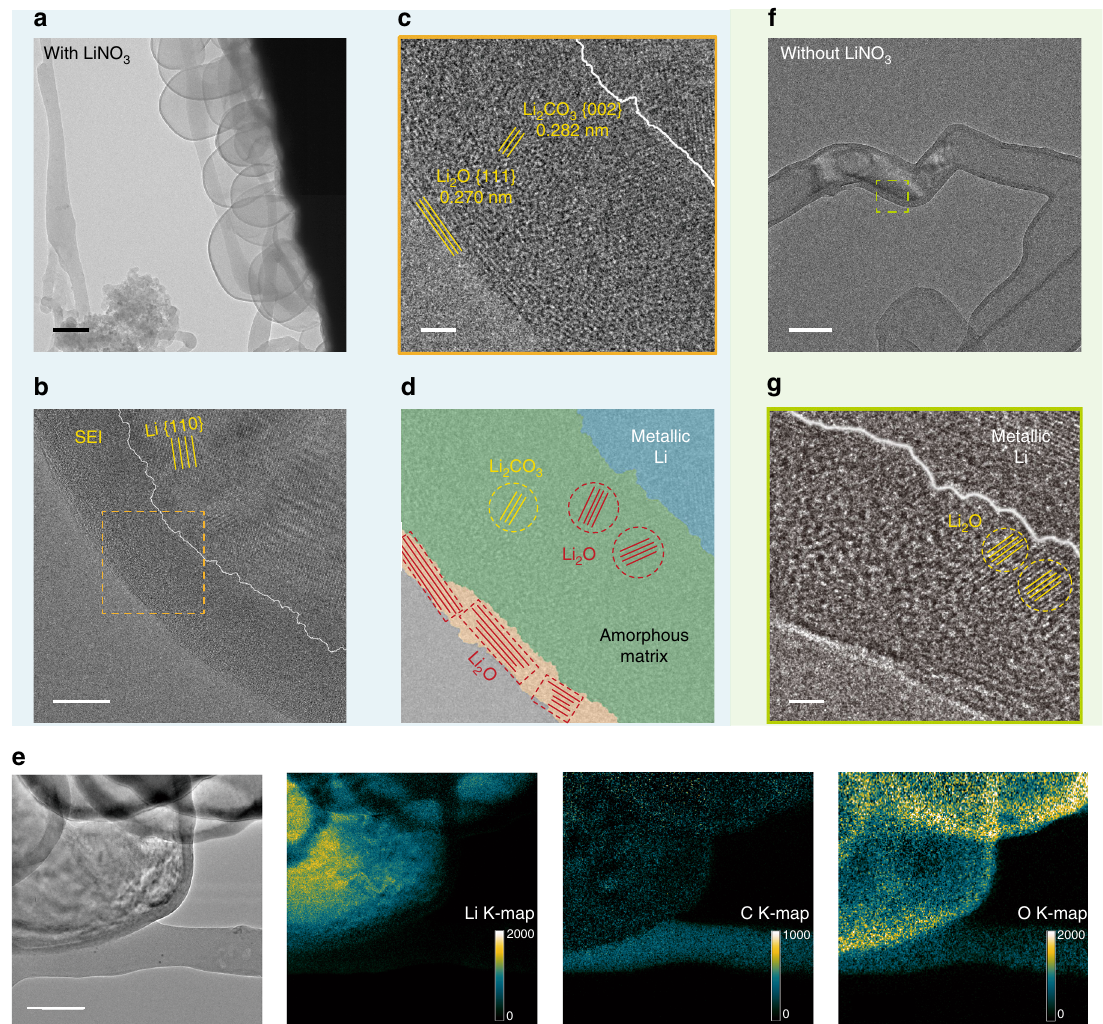
Fig. 4 Cryo-EM study on the SEI structure in the presence of nitrate. a Low-magni fi cation and b high-resolution TEM images of Li deposits in 0.5 M LiPF 6 EC/DEC electrolyte saturated with NO 3 – at a current density of 0.5 mA cm – 2 for 150 s. The white line in b delineates the boundary between metallic Li and SEI. Scale bars, 200 nm in a and 10 nm in b . c Magni fi ed TEM image and d the corresponding schematic of the orange region outlined in b showing the bilayered structure of SEI. The outside is a dense layer of Li 2 O displaying clear lattice fringes, and the inside is an amorphous matrix with crystalline domains (Li 2 O and Li 2 CO 3 ) dispersed randomly throughout. Scale bar, 2 nm in c . e Energy- fi ltered TEM mapping of elemental distributions of Li, C, and O across the Li deposits and the corresponding un fi ltered TEM image of the region. Scale bar, 100 nm. f Low-magni fi cation and g high-resolution TEM images of Li deposits in 0.5 M LiPF 6 EC/DEC electrolyte without NO 3 – . The SEI showed a mosaic model with crystalline domains dispersed in an amorphous matrix. Scale bars, 100 nm in f and 2 nm in